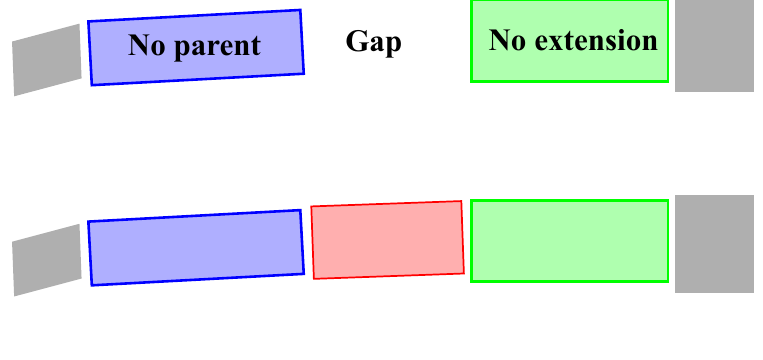
Figure 11. Filling gaps. The green cylinder ( A ) has no extension, and the nearby blue cylinder ( C ) has no parent. The gap between these two cylinders is filled by the red cylinder ( B ).